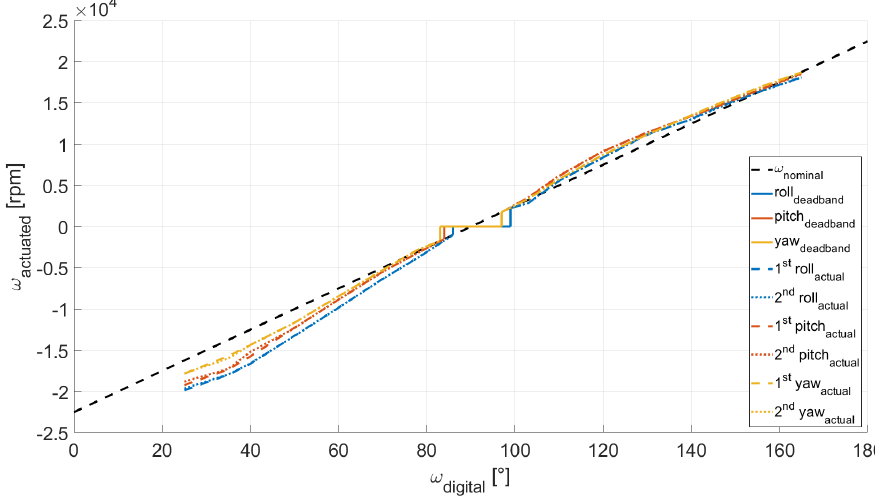
Figure 7. BLDC motors characteristic